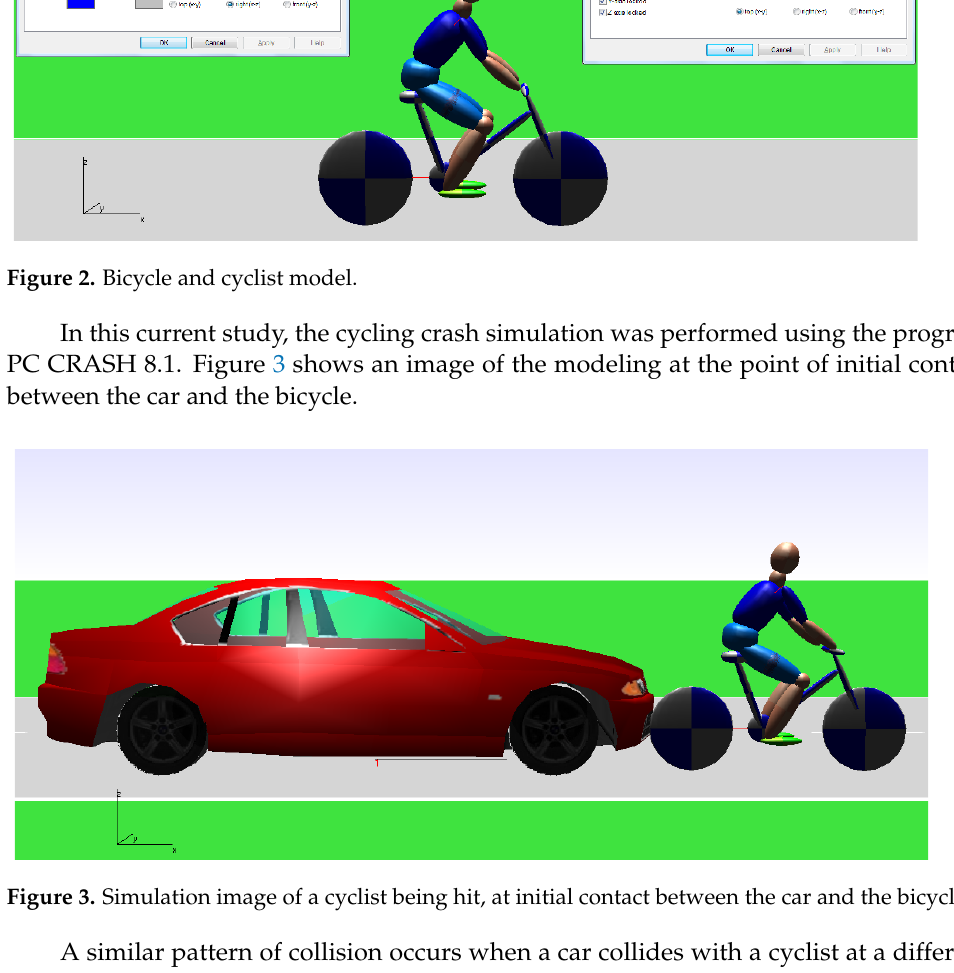
Figure 3. Simulation image of a cyclist being hit, at initial contact between the car and the bicycle.